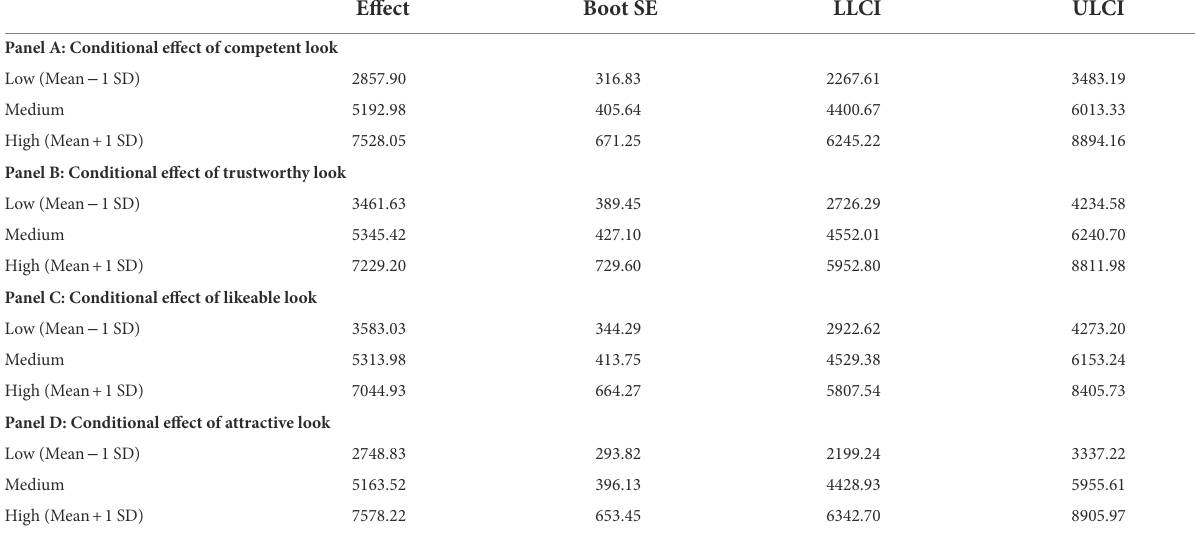
TABLE 5 Conditional indirect effect of various dimensions of broadcaster appearance when mediated by broadcaster